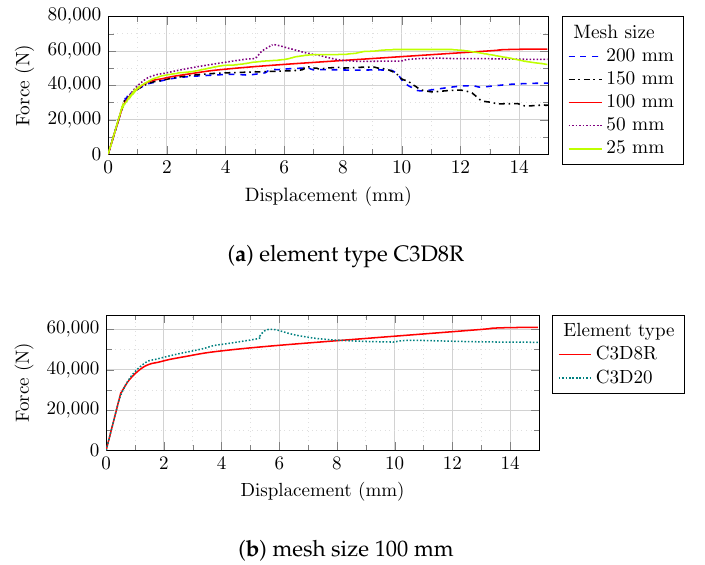
Figure 11. Mesh sensitivity analysis of the masonry prism: ( a ) different mesh sizes; ( b ) different element types.